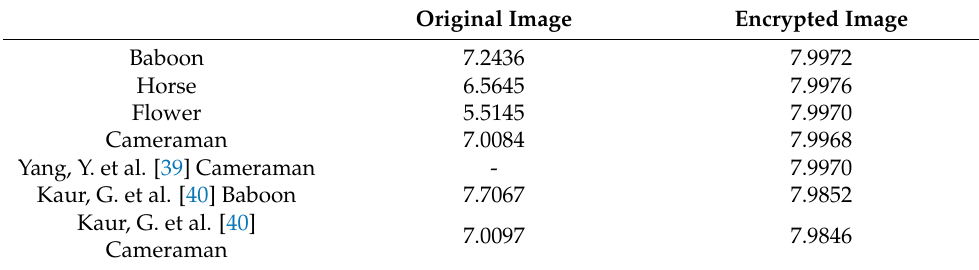
Table 7. Information